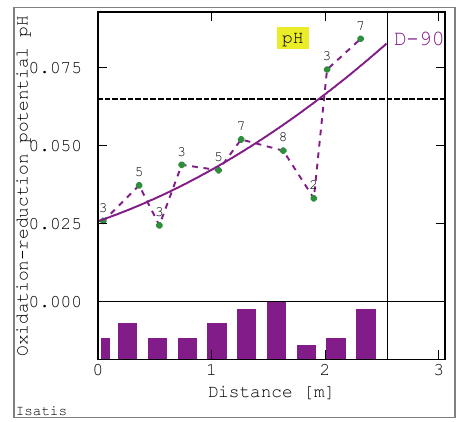
Fig. 21. Directional semivariogram (D-90) of nitrate